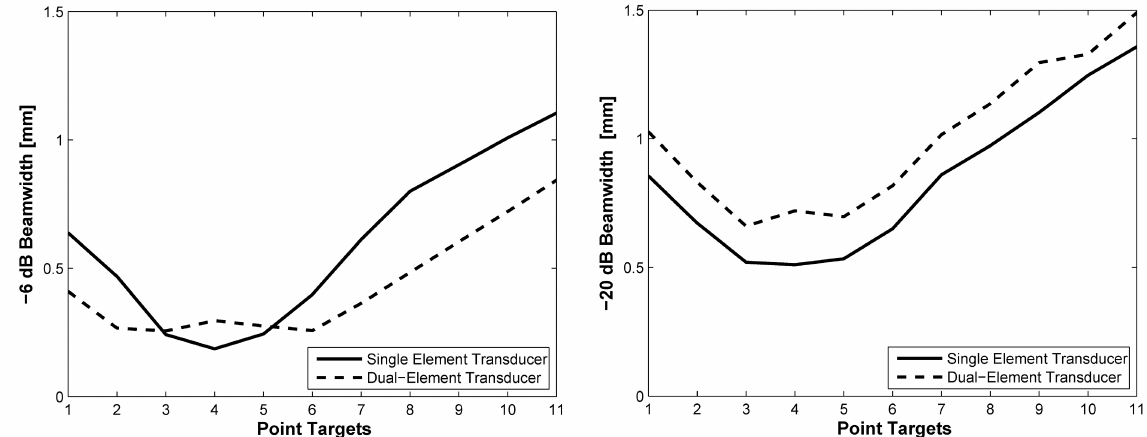
Figure 5. Plot of −6 dB and −20 dB lateral beamwidth throughout the depth of the image in Figure